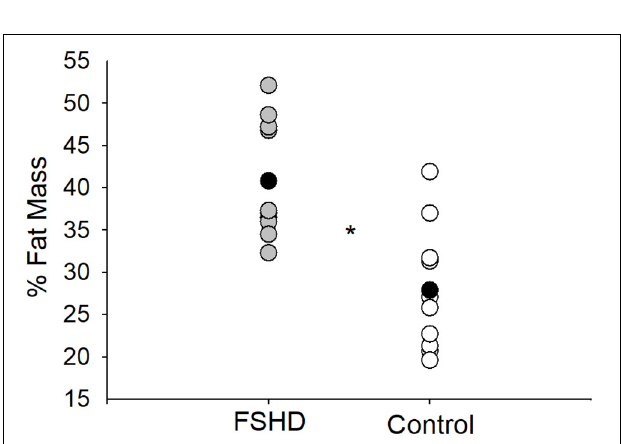
FIGURE 1 | Appendicular lean mass index (ALMI, kg/m 2 ) in FSHD and controls. Individuals with FSHD had lower lean mass as compared to controls. Black circles indicate average data for each group. * p < 0.01.